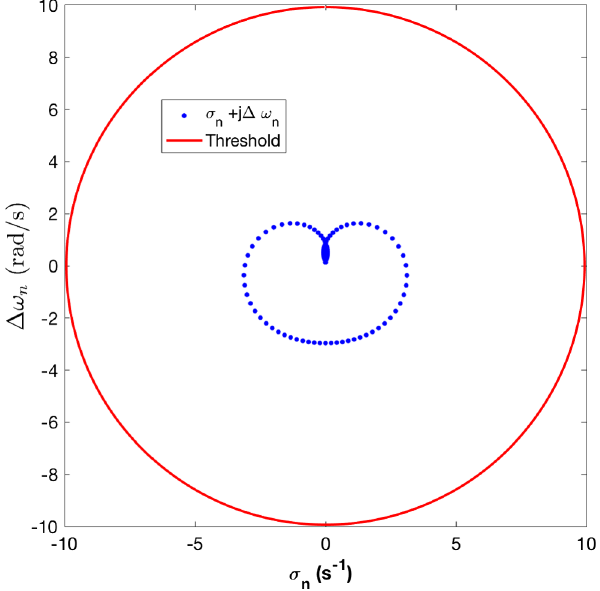
FIG. 12. Λ n ¼ σ n þ j Δ ω n and stability threshold. Configura- tion ( β ), OTFB Off.